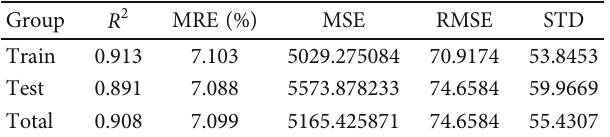
Table 2: Comparing the accuracy of di ff erent models in predicting the target parameter. Model